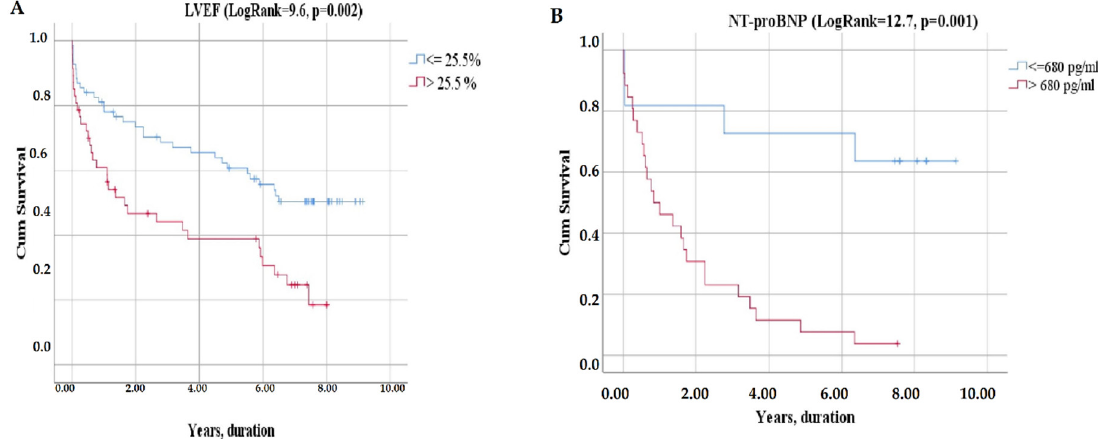
Figure 4. Kaplan–Meier curves of event-free survival according LVEF ( A ), NT-proBNP ( B ). Eight-year survival was 2% for those with VO 2 peak < 16 mL/kg/min, 23% for those with VO 2 peak ≥ 16 mL/kg/min, 3% for patients with VE/VCO 2 slope ≥ 38.5, and 24% for those below this cut-off (Figure 5).